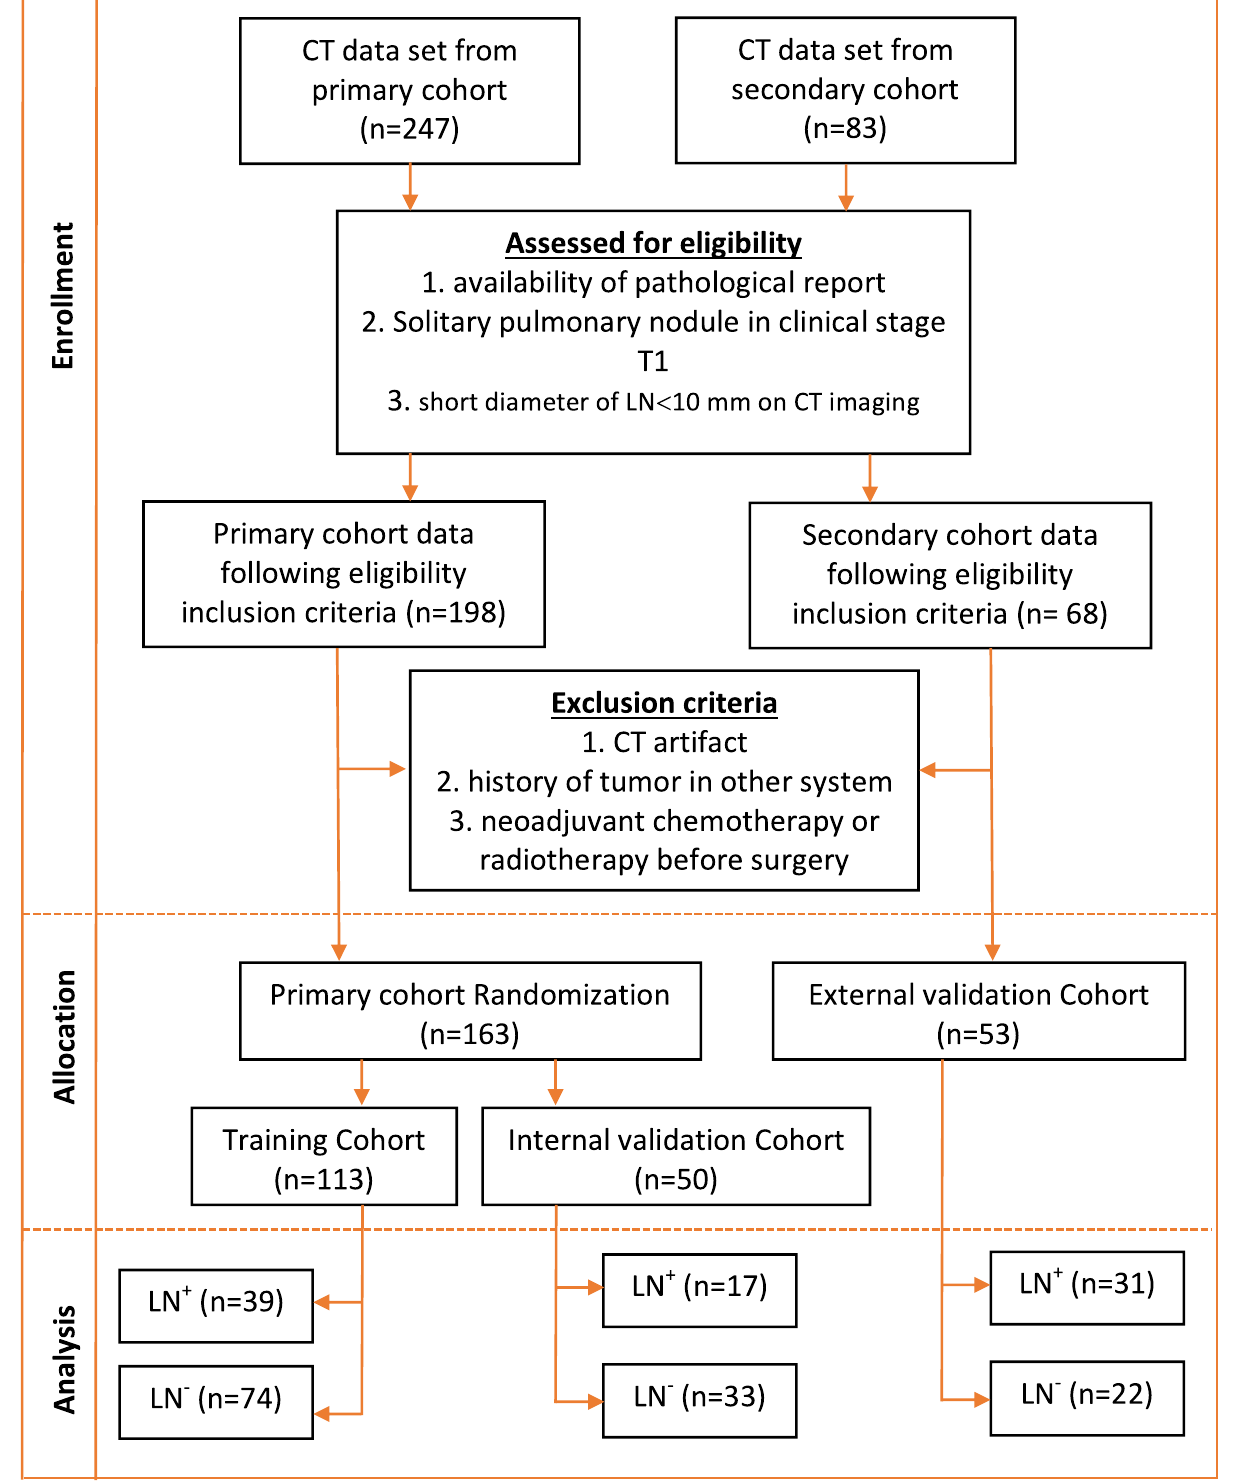
Figure 1. Consolidated standards of reporting trials, or CONSORT, flow diagram of patient enrollment, eligibility, and exclusion criteria of data